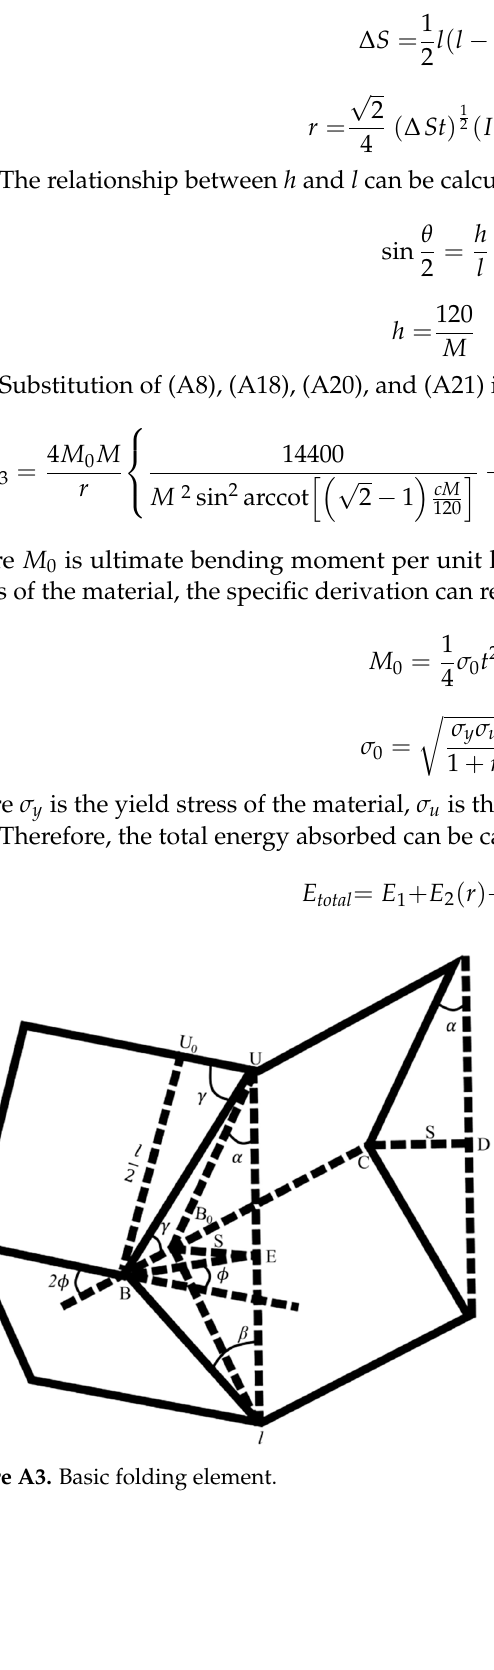
( a ) ( b ) Figure A4. ( a ) Plastic hinge line before moving; ( b ) plastic hinge line after moving. References 1.